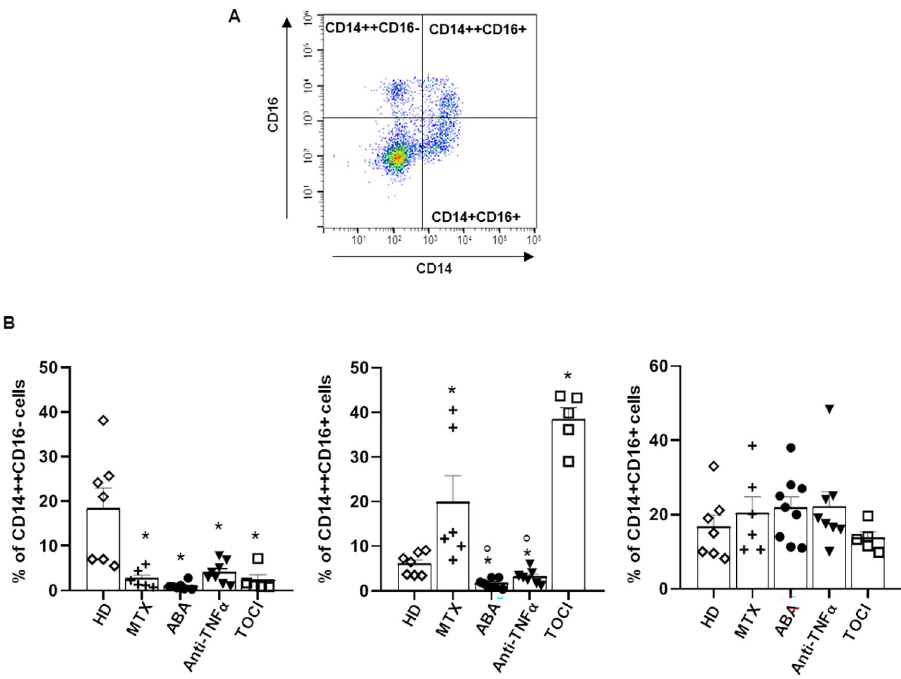
Fig 1. Flow cytometry evaluation of monocytes population from healthy donors and RA patients. A) Representative dot plot of gating strategy. B) Percentage of the indicated populations over CD14/CD16 positive cells. Data are means ± SEM of at least 5 independent experiments (HD = 7; MTX = 8; ABA = 7; anti-TNF α = 9; TOCI = 5) from distinct donors, analysed by one-way ANOVA with Dunnett’s test for multiple comparison. � p -value < 0.05 versus healthy donors (HD); ˚ p -value < 0.05 versus MTX (methotrexate). ABA, abatacept; TOCI, tocilizumab.